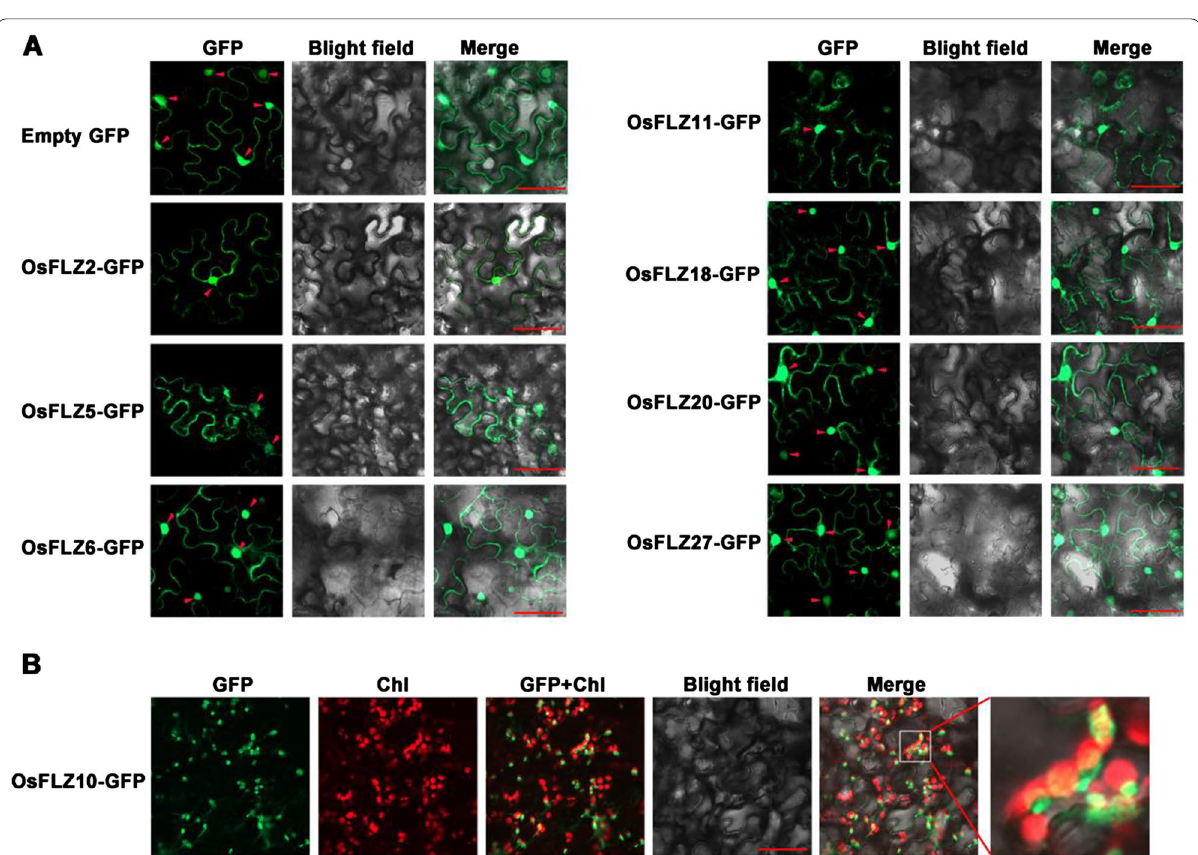
Fig. 3 Subcellular localization of OsFLZ-GFP proteins. a OsFLZ-GFP fusion constructs or empty GFP were expressed transiently in tobacco epidermal cells, respectively. The signals of GFP and chlorophyll autofluorescence (Chl) were captured with a confocal laser scanning microscopy and shown in green and red, respectively. Red arrows point to the cell nucleus. b OsFLZ10-GFP was partially co-localized with chloroplast. Scale bars: 50